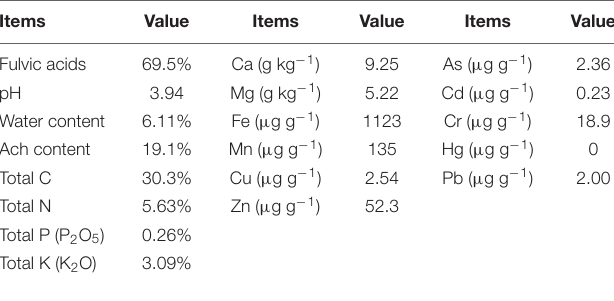
TABLE 1 | The chemical properties of fulvic acids of Zhongliang used in this study.